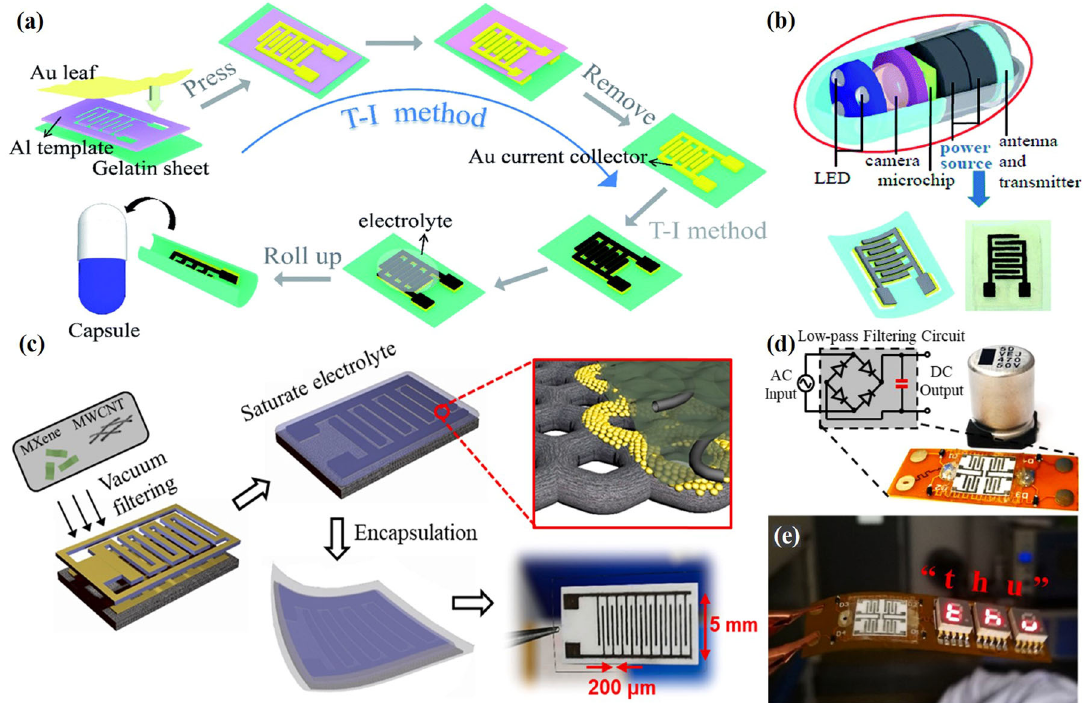
Fig. 7 Applications of MSCs in medical assistant and AC line- fi ltering. a The schematic illustration of fabrication of EMSC. b Structure diagram of commercial gastroscope powered by the EMSC. c Schematic diagram showing the fabrication process of high-frequency MSC. d Circuit diagram and photograph of a low-pass fi ltering circuit. An electrolytic capacitor of 0.47 mF is shown for comparison. e A LED array is powered through fl exible power fi ltering circuit with AC input. a , b Reproduced with permission 137 (Copyright © 2020, Royal Society of Chemistry). c – e Reproduced with permission 141 (Copyright © 2019,